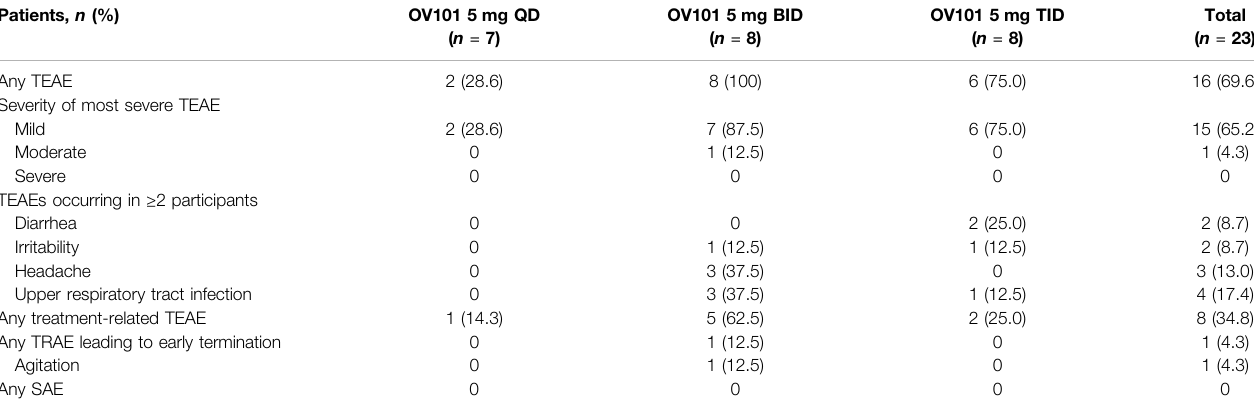
TABLE 3 | Summary of OV101 safety and tolerability. Patients, n (%)